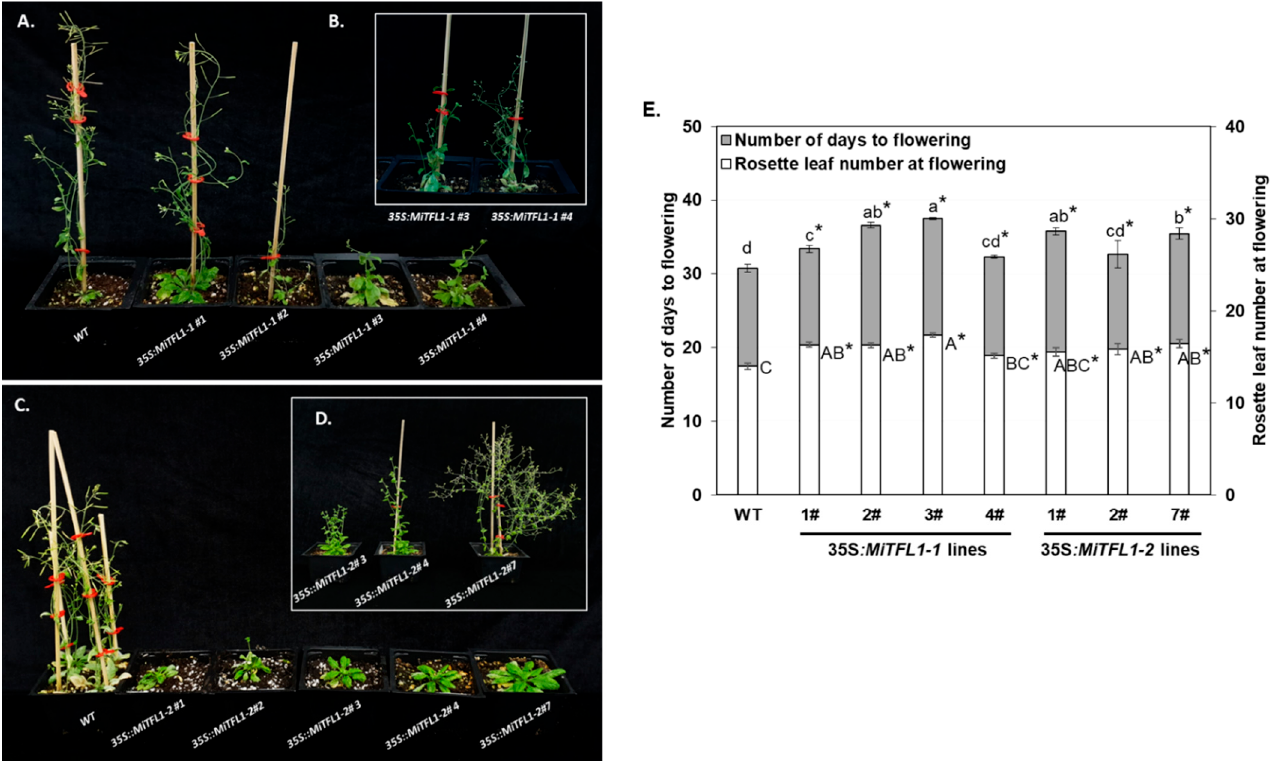
Figure 4. Ectopic expression of ‘Shelly’ MiTFL1-1 and MiTFL1-2 genes in Arabidopsis . 35S: MiTFL1-1- and 35S: MiTFL1-2 -transformed plants exhibit late flowering phenotype relative to WT plants and display branched phenotype and/or shoot-like inflorescences. Photographs were taken 66 and 72 days from sowing ( A , C ), and 94 and 103 days from sowing ( B , D ). Comparison of flowering phenotypes of Arabidopsis Col-0 (WT), four lines constitutively expressing MiTFL1-1 and three lines constitutively expressing MiTFL1-2 , under LD conditions ( E ). Values represent means + SE of number of days to flowering and number of rosette leaves at flowering; n = 17–35 plants per line. Different small or capital letters indicate significant differences of number of days to flowering or rosette leaf number at bolting, using Tukey–Kramer multiple comparison test, with p ≤ 0.05. Asterisks (*) denote a significant difference between the control and a specific 35S: MiTFL1-1- or MiTFL1-2 -overexpressing line, using least significant difference (LSD) test, according to pairwise comparison by Student’s t -test, with p ≤